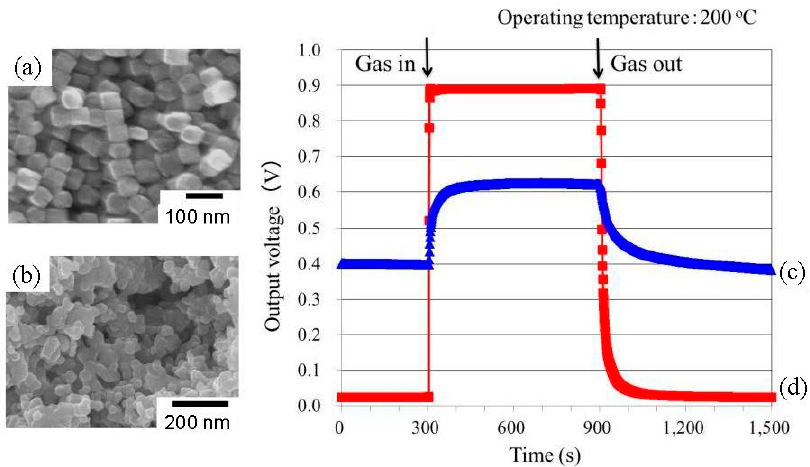
Figure 2. FE-SEM images of ( a ) SnO 2 nanocubes annealed at 250 °C for 3 h and ( b ) commercial SnO 2 nanoparticles calcined at 1100 °C. Response- recovery transients of ( c ) and ( d ) to respective gas mixture of 1000 ppm H 2 and